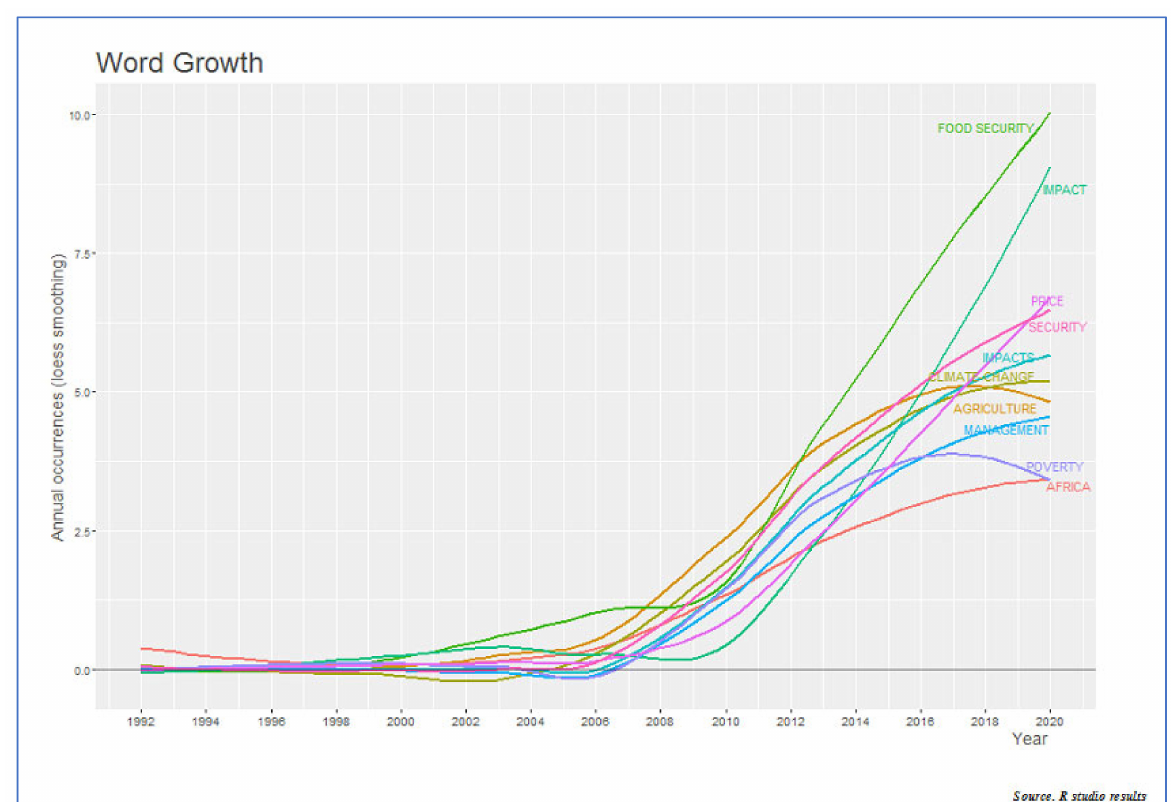
Figure 7. Change and evolution of keywords over time. Source R studio